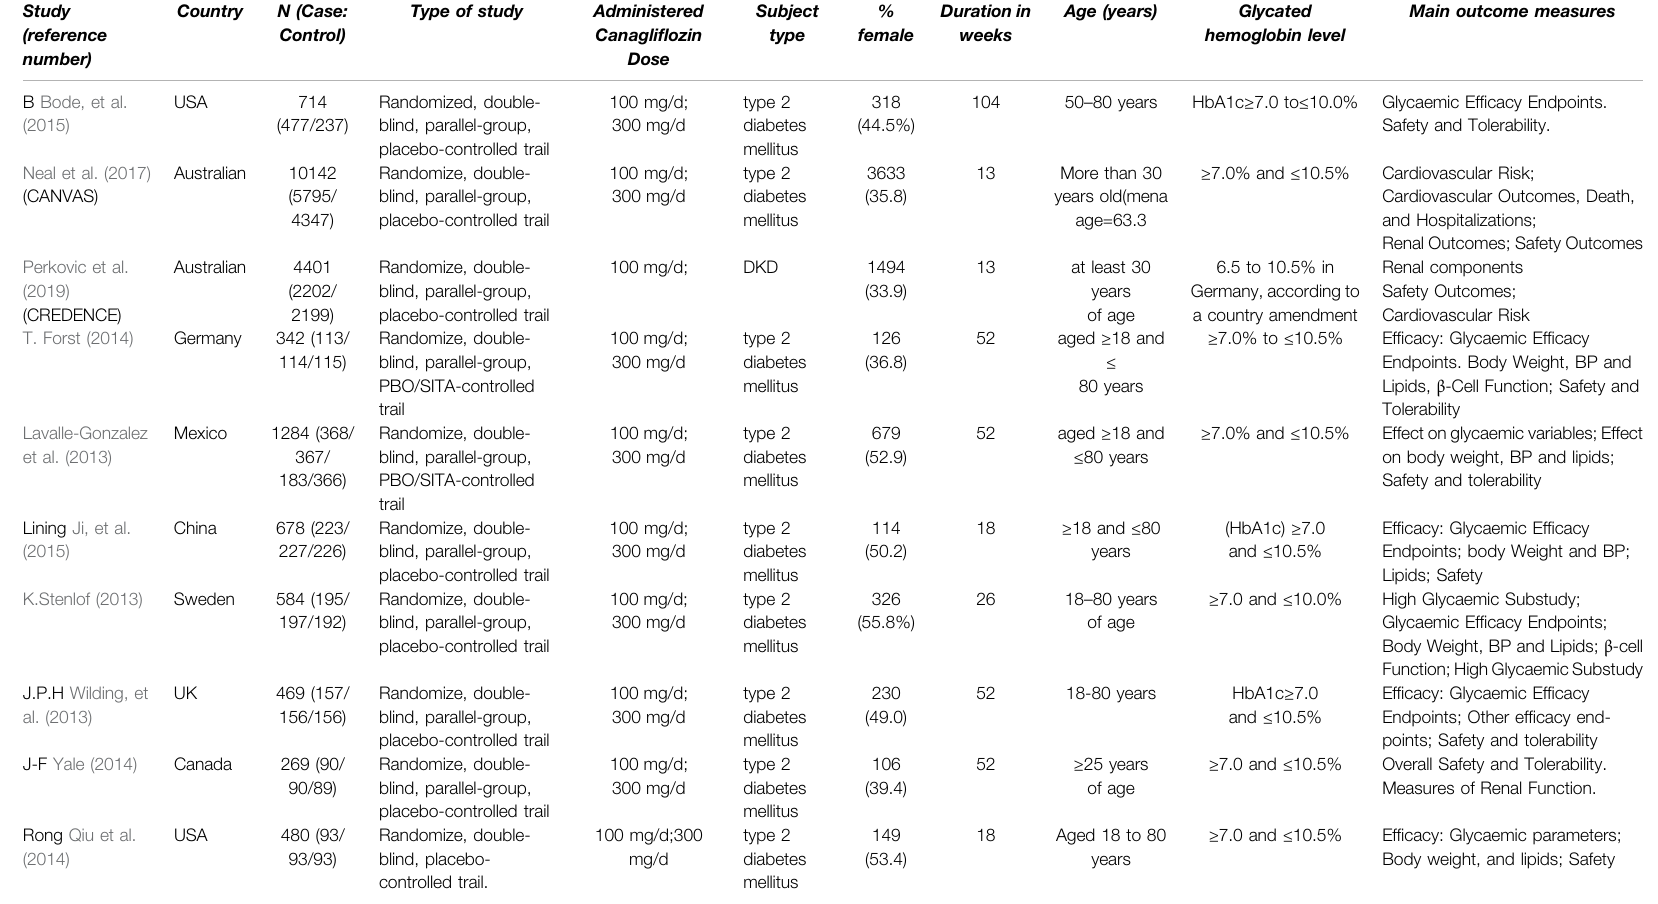
TABLE 1 | Characteristics of included randomized controlled